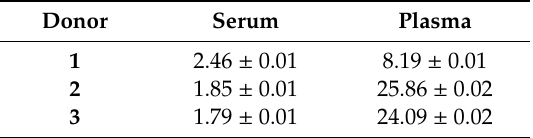
Table 2. Percentage (mean ± SEM, n = 3) of infectious particles in aggregates for viruses incubated with serum or plasma from three different donors.